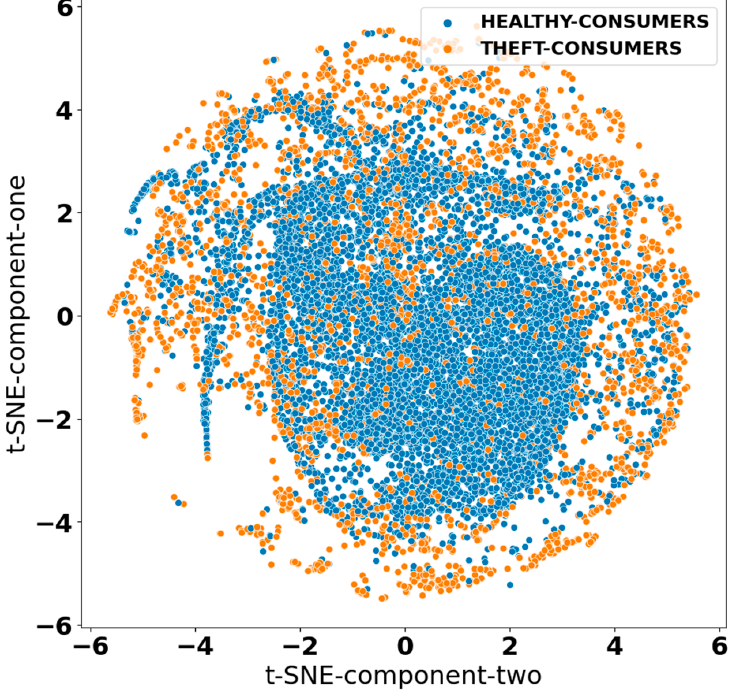
Figure 8. Data class distribution after using MWMOTE algorithm (balanced dataset).